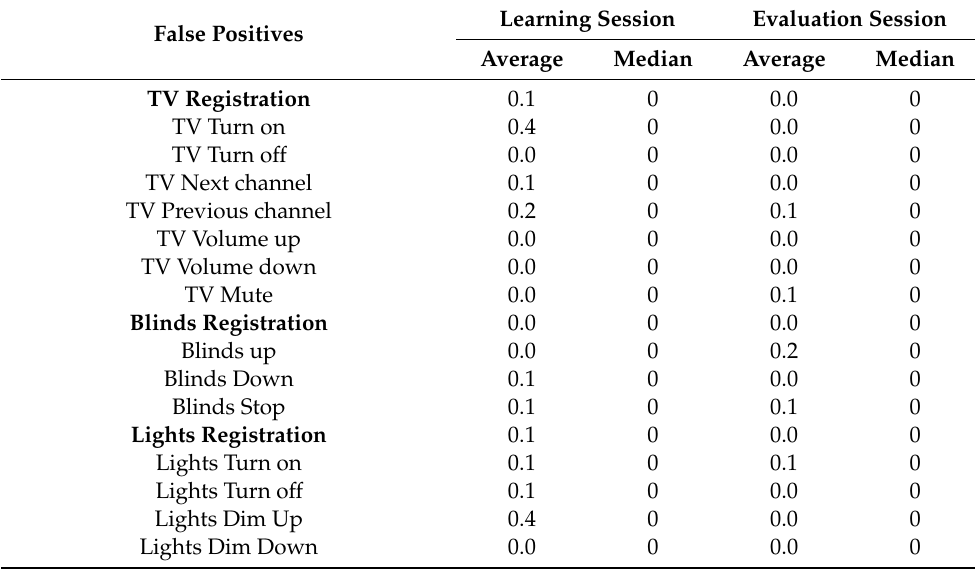
Table 6. False positive errors (average, median) for learning and evaluation session of mid-air interaction with multiple